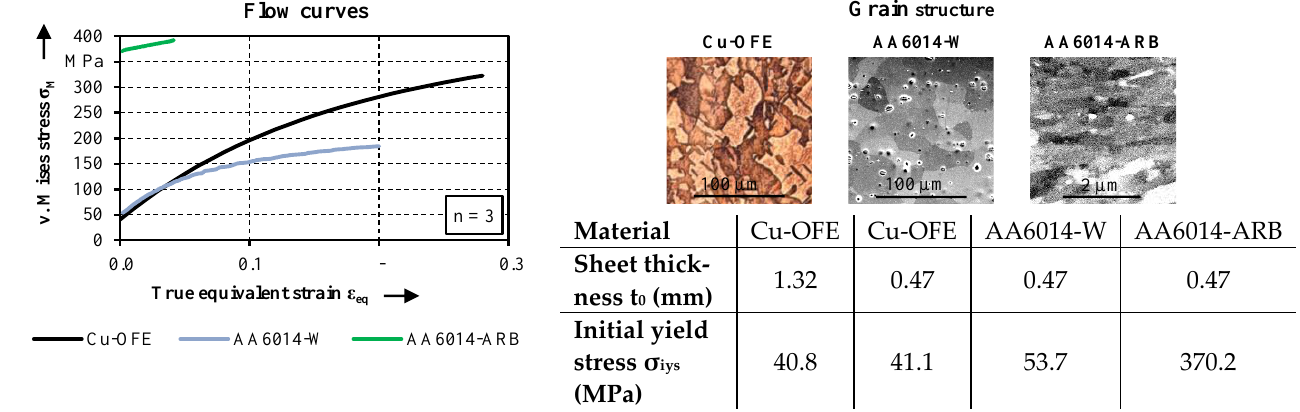
Figure 3. Flow curves, grain structure and initial yield stress of the used materials.